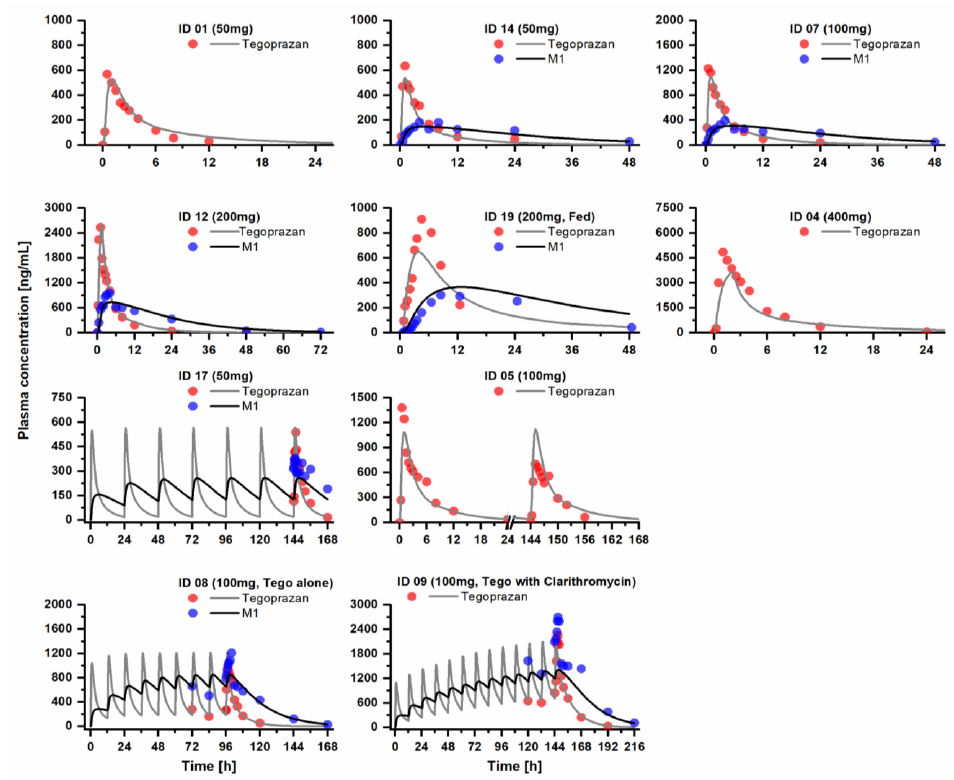
Figure 1. In terms of the training dataset, the predicted and observed plasma concentration–time curves of tegoprazan and the metabolite M1 after the oral administration of tegoprazan in healthy subjects are shown. Solid lines are the predicted values of each model. Circles are clinical observations. Details on dosing regimens, characteristics, subject demographics, and references are listed in Table S1. The PK profile of M1 in the ID 09 was not used for model development. The simulation for M1 in this ID was performed based on the developed PBPK models of tegoprazan and M1.